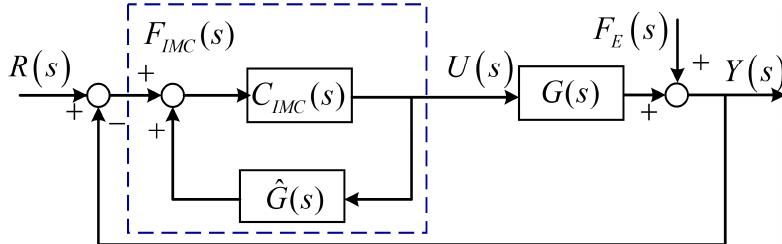
Figure 2. Schematic diagram of the internal model control method.